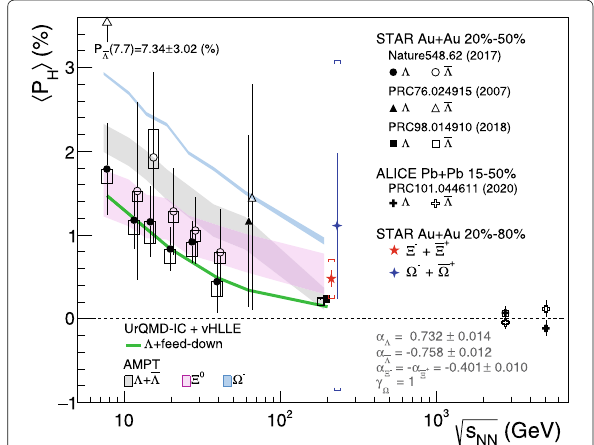
Fig. 12 Global polarization as a function of the collision energy for (cid:6) and ¯ (cid:6) hyperons as well as for (cid:14) and (cid:7) hyperons [84, 85, 91–93]. Solid line and shaded bands denote calculations from viscous hydrodynamic model (vHLLE) with UrQMD initial condition [86] as well as a multi-phase transport (AMPT) model [87] respectively. Decay parameters α and γ of each particles [94] used in the measurements are shown in the figure. Note that the old results are corrected for recent update of the decay